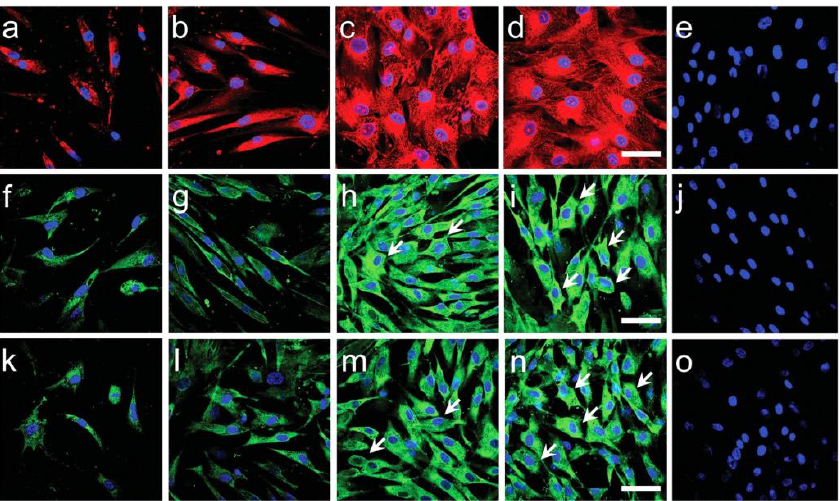
Figure 4. Reprinted with permission. Bishi DK et al, Adv Healthc Mater. 2016; 1058-70. Hepatocyte- specific marker expression (α -fetoprotein, albumin and cytokeratin-18) in BMSCs-derived hepato- cyte-like cells as shown by confocal microscopy images (merged) on a), f) and k) PLLA scaffold with recombinant hepatic growth factor induction, b), g) and l) PLLA scaffold with hepatogenic serum induction, c), h) and m) PLLA/gelatin with recombinant hepatic growth factor induction, d), i) and n) PLLA/gelatin scaffold with hepatogenic serum induction at day 28. Alexa Fluor- 594 labelled α - fetoprotein (a, b, c and d: red), Alexa Fluor-488 labelled albumin (f, g, h and i: green) and Alexa Fluor-488 labelled cytokeratin-18 (k, l, m and n: green) expression represents features of hepatocyte- like cells. e), j) and o) Undifferentiated BMSCs on PLLA/gelatin scaffolds did not express any hepatic markers. Nuclei were stained with DAPI (blue). Compared to PLLA scaffolds, more mature hepato- cyte-like cells with cuboidal-to-polygonal morphology were observed (shown by white arrows) on PLLA/gelatin scaffolds in either induction condition (scale bar = 100 μm.) [81] .